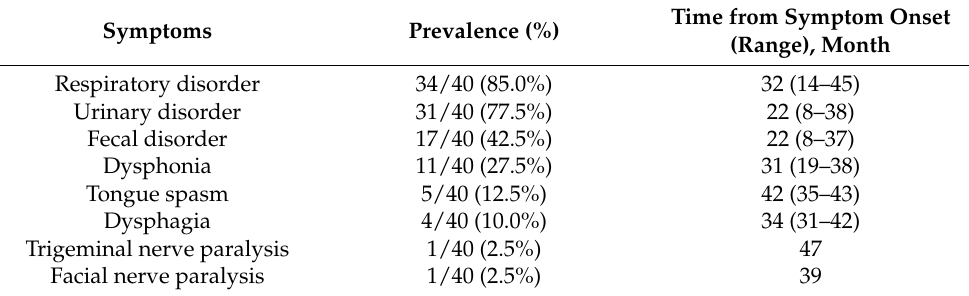
Table 1. Prevalence and time from symptom onset other than gait disorder.